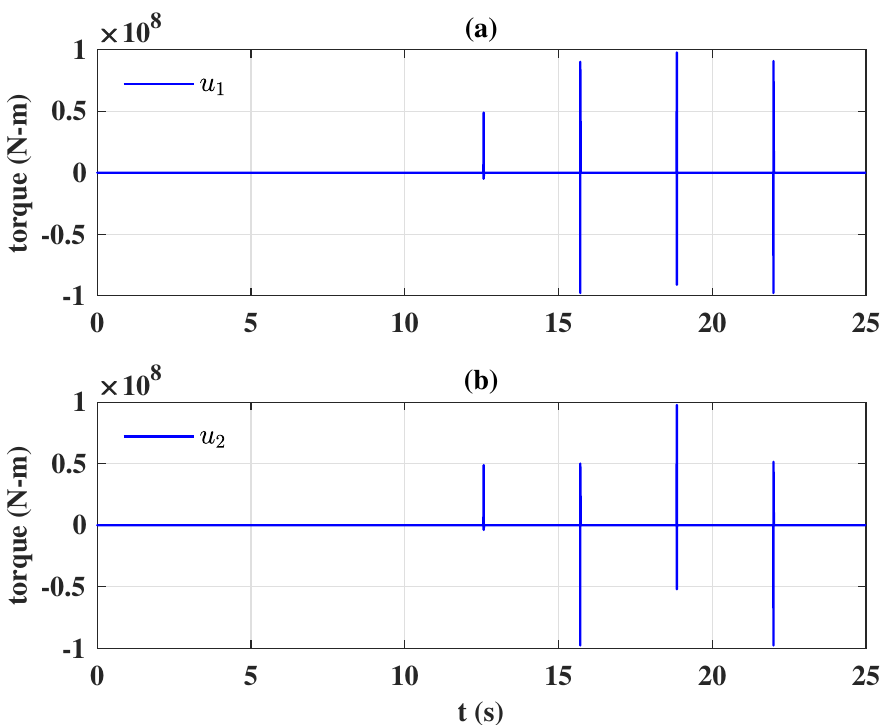
Figure 7. Time history of the control signals ( a ) u 1 and ( b ) u 2 with the extended references.